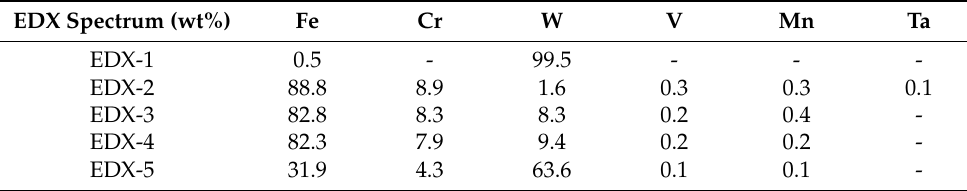
Table 3. EDX spectrum analysis at different locations marked in Figure 7.